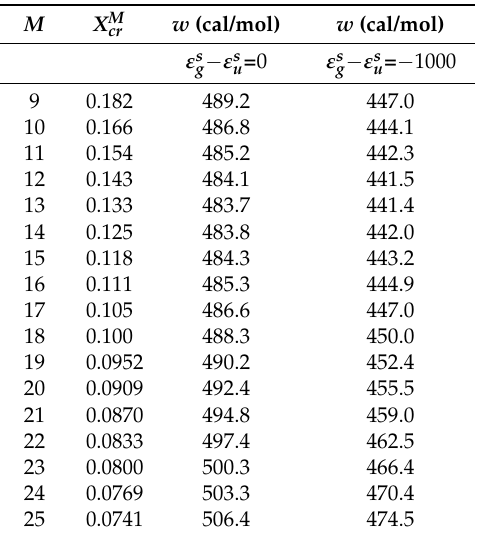
Table 1. Cluster Characteristics at Coordination Number z = 4.